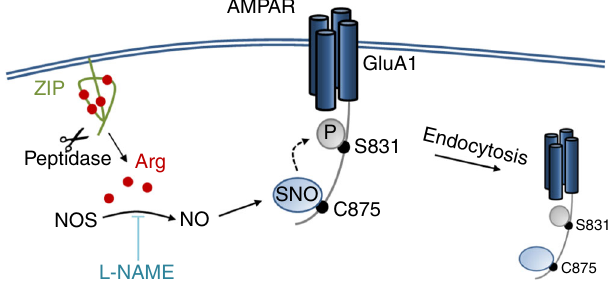
Fig. 6 Model for the molecular mechanism of ZIP. Myristoylated ZIP binds to the cell membrane and is digested by peptidases to produce free arginine residues (red circles). Arginine is a substrate of nitric oxide synthase (NOS), which generates nitric oxide (NO). NO in turn, nitrosylates the cysteine residue on position 875 on the cytoplasmic tail of the AMPAR GluA1 subunit, which induces serine phosphorylation of GluA1 on position 831. S831 phosphorylation leads to endocytosis of AMPARs and subsequent functional